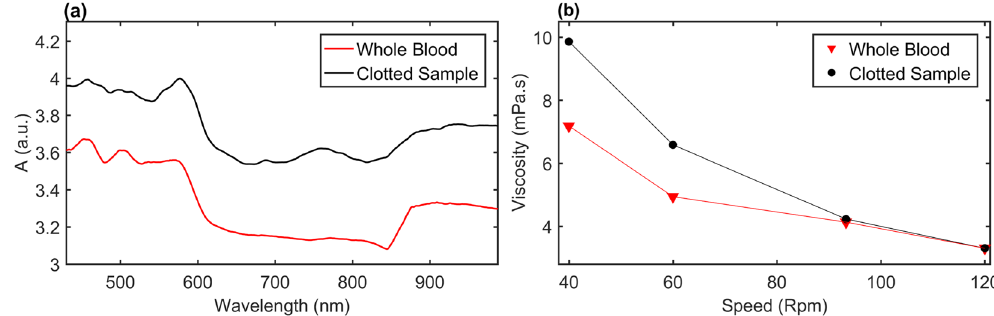
Figure 1. Optical Spectra and viscosity measurements. ( a ) Optical Spectra for a sample of whole equine blood and a fully clotted equine sample. ( b ) Shear controlled viscosity measurement, for whole equine blood and a fully clotted